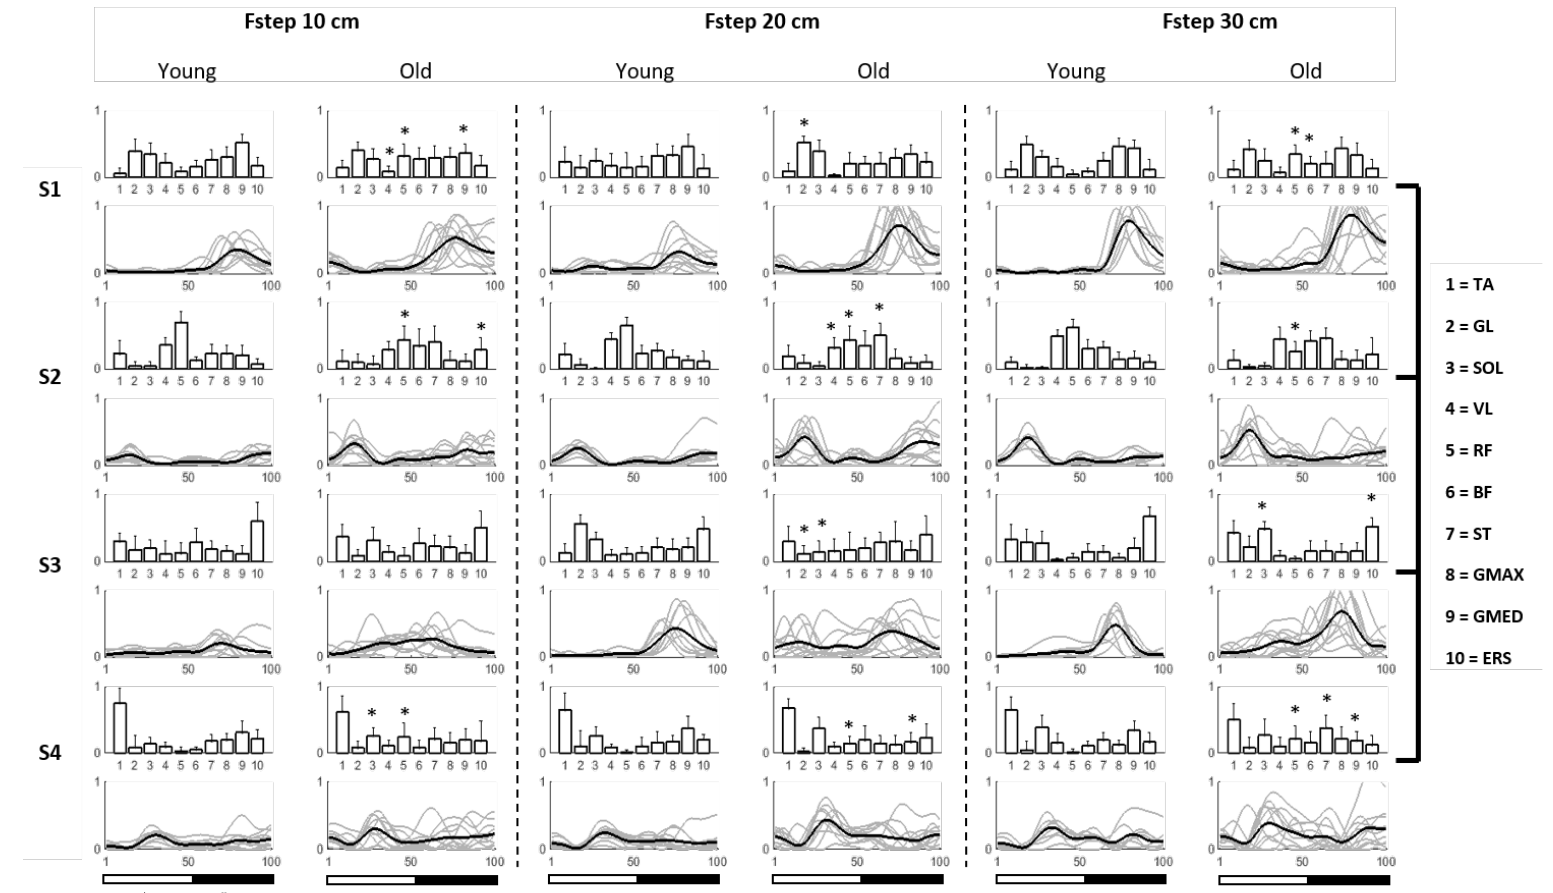
Figure 3. Muscle weightings and temporal activation patterns for four synergies ( S1 – S4 ) extracted during forward stepping (Fstep). Each set of two columns 3 represents muscle synergies extracted from step heights of 10, 20 or 30 cm per age group with young women represented in the left column and older women in the right column. * indicates a significant di ff erence between contributions of individual muscles between age groups. Time-averaged foot clearance (white bars) and pull-up (black bars) phases of ascent are depicted at the bottom. TA = tibialis anterior, GL = gastrocnemius lateralis, SOL = soleus, VL = vastus lateralis, RF = rectus femoris, BF = biceps femoris, ST = semitendinosus, GMAX = gluteus maximus, GMED = gluteus medius, ERS = erector